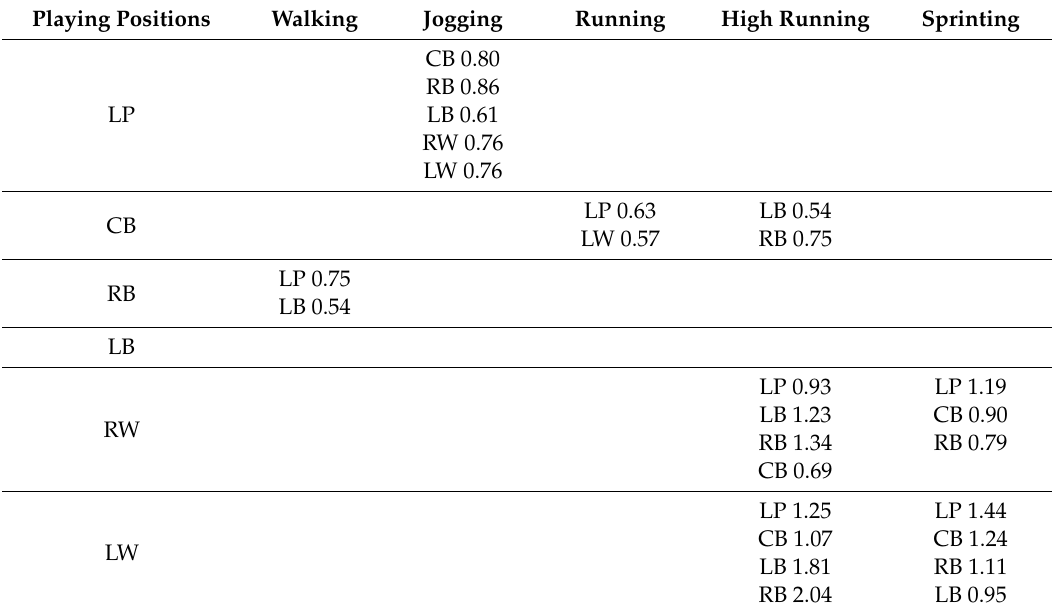
Table 2. E ff ect sizes in di ff erent locomotion categories by playing position in o ff ense. Playing Positions Table 2. Effect sizes in different locomotion categories by playing position in offense. Playing Positions